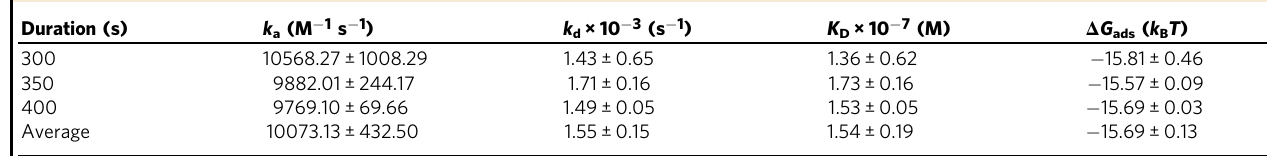
Table 2 Kinetics extracted from MP-SPR